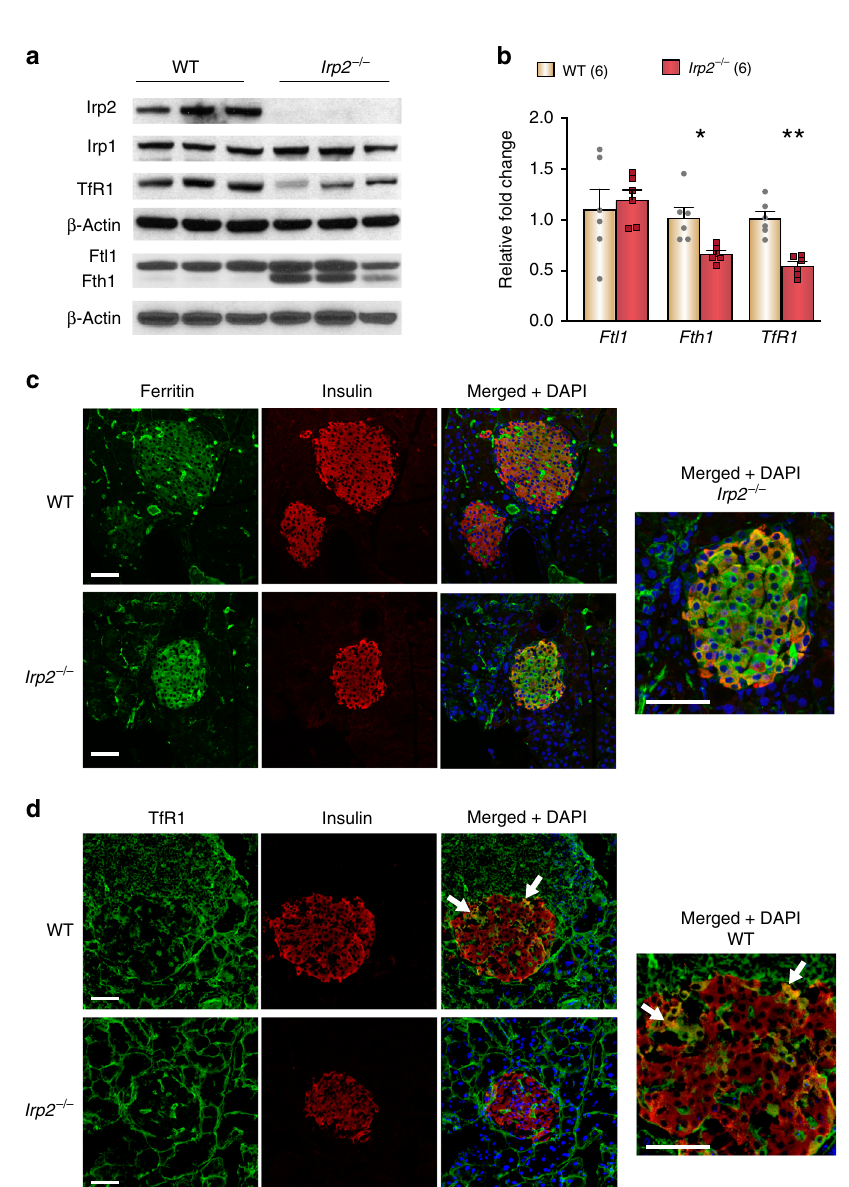
Fig. 4 Cellular iron homeostasis is dysregulated in Irp2 − / − islets. a Western blot analysis of Irp2, Irp1, TfR1, ferritin (Fth1 and Ftl1) in WT, and Irp2 − / − islets from 8-month-old mice ( n = 3 mice per genotype). β -Actin is a loading control. Note that murine Fth1 migrates slightly faster than Ftl1 on SDS- PAGE 67 . b qPCR of Ftl1 , Fth1 , and TfR1 in WT and Irp2 − / − islets from 8-month-old mice. Values are normalized to β -actin mRNA and expressed as relative fold change to WT islets ( n = 6 mice per genotype). Data are expressed as means ± s.e.m., unpaired two-tailed Student ’ s t test, * p < 0.05, ** p < 0.01. c , d Representative paraf fi n-embedded pancreatic sections from 8-month-old WT and Irp2 − / − mice immunostained with antibodies to ferritin (green) and insulin (red) ( c ) or antibodies to TfR1 (green) and insulin (red) ( d ). The insulin antibody detects both insulin and proinsulin. Nuclei are stained with DAPI (blue). Scale bar: 50 µ m. Source data are provided as a Source Data fi